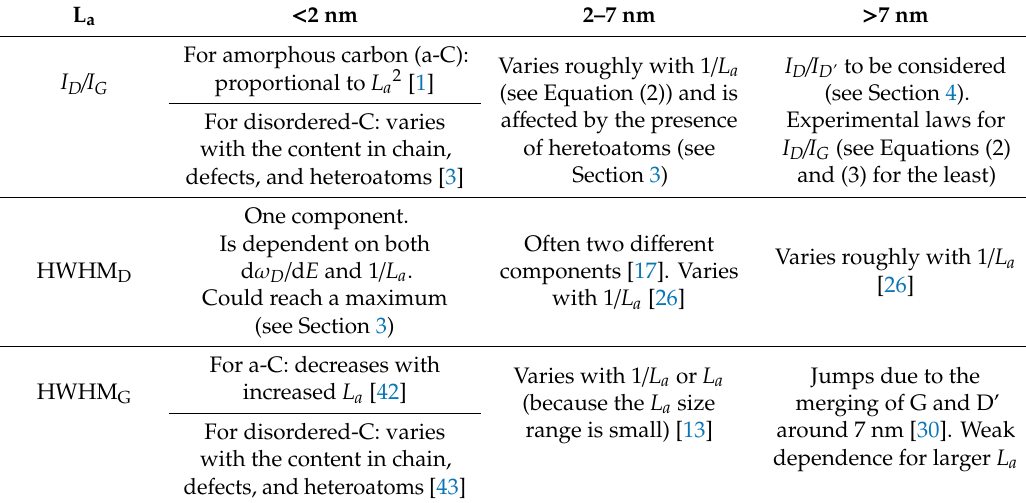
Table 4. Trends of evolution with crystallite size of the three main parameters associated with a Raman